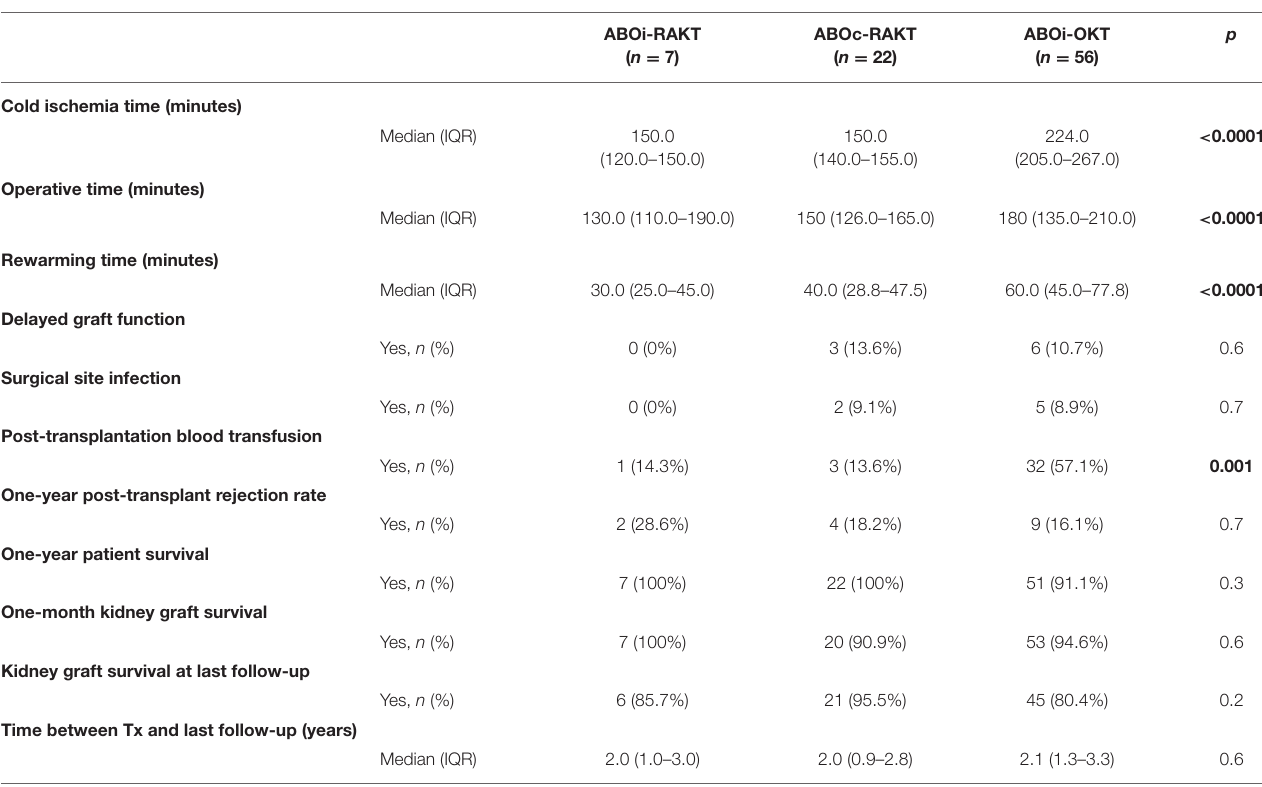
TABLE 2 | Intra-, post-operative, and functional